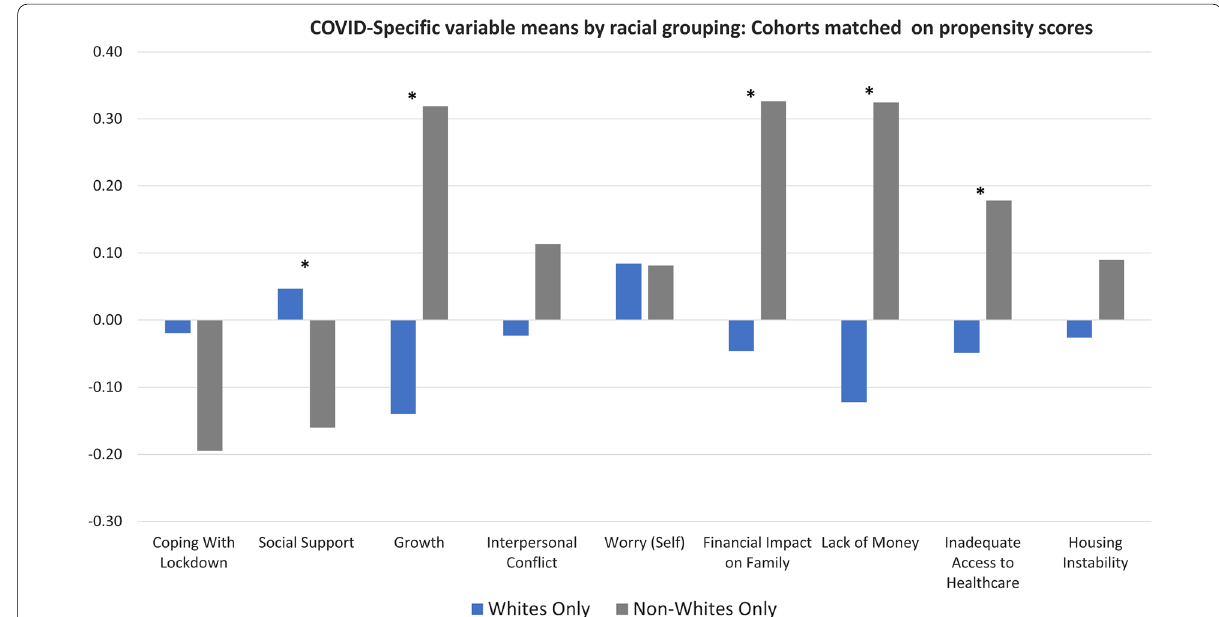
Fig. 4 COVID-specific variables by racial grouping: Cohorts matched on propensity scores. Asterisks indicate group comparisons with eta 2 of at least a small ES (i.e., ≥